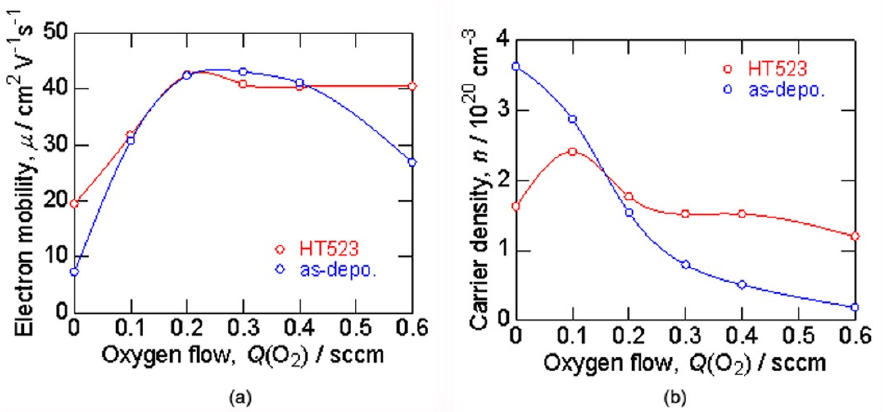
Figure 2. ( a ) The electron mobility and ( b ) the carrier density of the as-depo. and HT523 ITO50:Al 2 O 3 (PHS) thin films depending on Q (O 2 ).